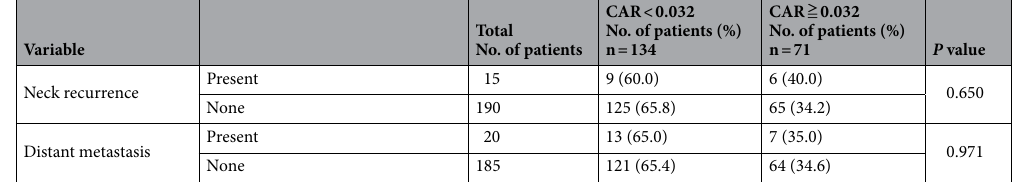
Table 1. Clinical characteristics of the patients included in the study dichotomized according to the cutoff value of CAR. * P < 0.05 Statistically significant difference. ** P < 0.01 Statistically significant difference. NLR, neutrophil/lymphocyte ratio; SIRI, systemic Inflammation Response Index; LMR, lymphocyte/ monocyte ratio; SII, systemic immune-inflammation index; CAR, C-reactive protein/albumin